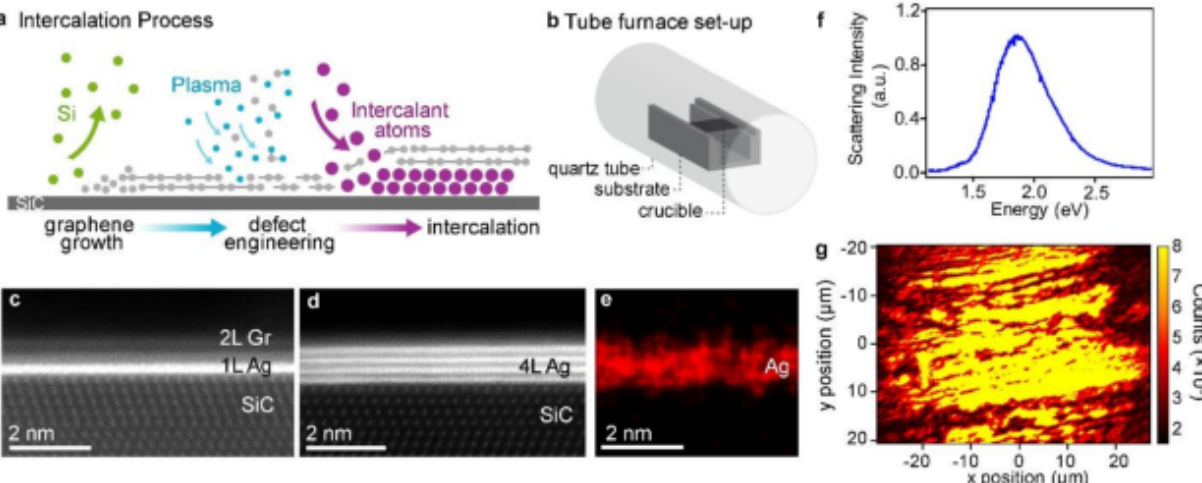
Figure 17. ( a ) Intercalation schematic illustrating graphene growth, plasma treatment, and metal intercalation ( b ) Diagram of experimental setup depicting a quartz tube containing an alumina crucible and an EG/SiC substrate placed facing downward on the crucible over the metal source. ( c ) Cross-sectional STEM showing 1 and ( d ) 4 layers of Ag between EG and SiC. ( e ) Corresponding Ag EDS. ( f ) Dark field scattering spectrum showing a peak at 1.87 eV, reflecting the plasmonic character of the Ag film. ( g ) Map of SHG peak across the EG/Ag/SiC surface showing the presence of Ag layers across 10s of microns. “Reproduced with permission from [188], [Nanoscale]; published by [Royal Society of Chemistry], 2019”.